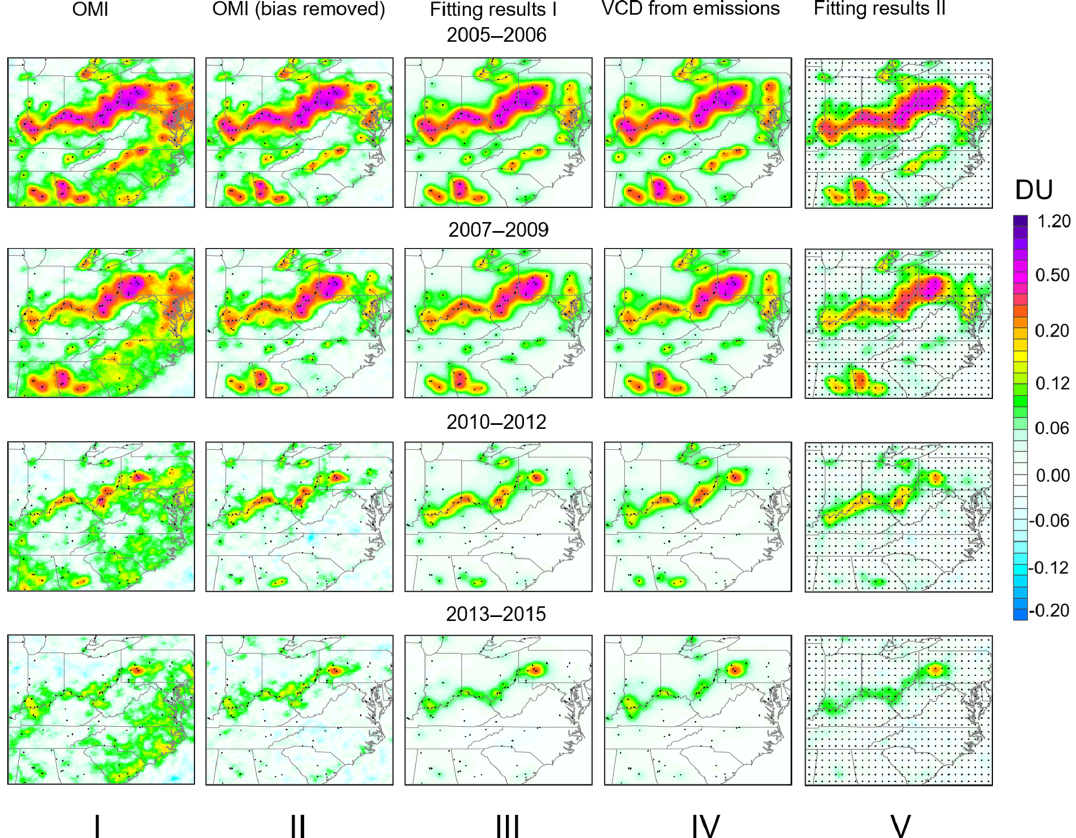
Figure 1. Annual mean OMI SO 2 VCDs from PCA algorithm (column I), mean OMI SO 2 VCDs with a large-scale bias removed (column II), results of the fitting of OMI data by the set of functions that represent VCDs near emission sources using estimated emissions (see text) (column III), and SO 2 VCDs calculated using the same set of functions but using reported emission values (column IV). Point sources that emitted 20ktyr − 1 at least once in the period 2005–2015 were included in the fit (they are shown as the black dots). Results of the fitting of OMI data by the set of functions that represent “sources” as 0.5 ◦ by 0.5 ◦ grid cells (shown as the black dots) using estimated emissions (see text) are shown in column V. The maps are smoothed by the pixel averaging technique with a 30km radius (Fioletov et al., 2011).